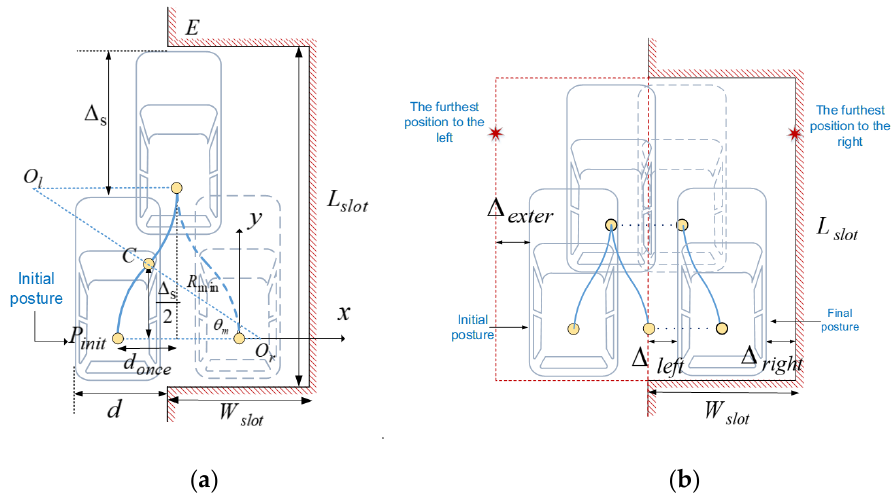
Figure 2. S-shaped forward and backward movement ( a ); and schematic representation of the space required for parking ( b ).